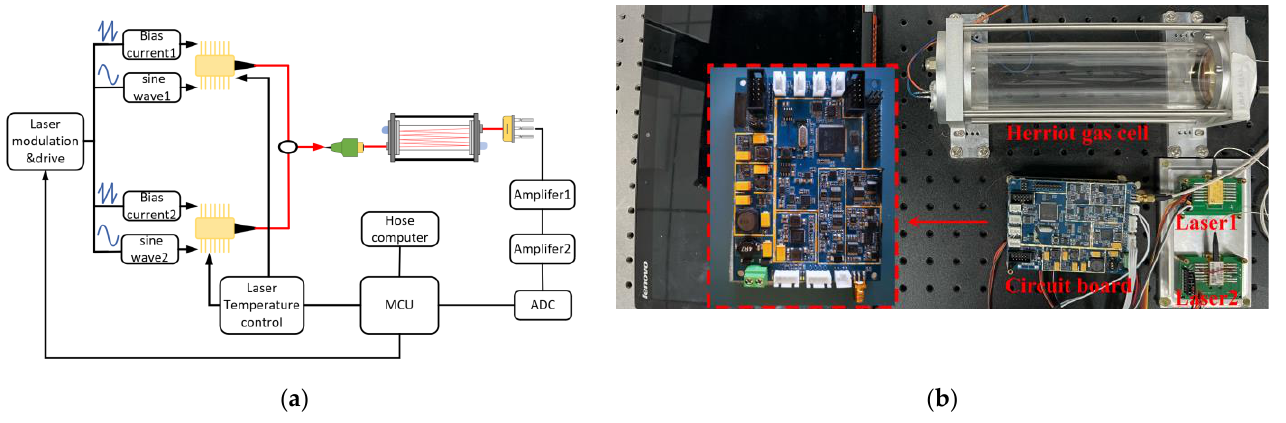
Figure 2. The structure of the designed multi-gas sensor: ( a ) Schematic structure of the FDM-WMS multi-gas detection system.; ( b ) Photo of the detection platform and the homemade circuit board.